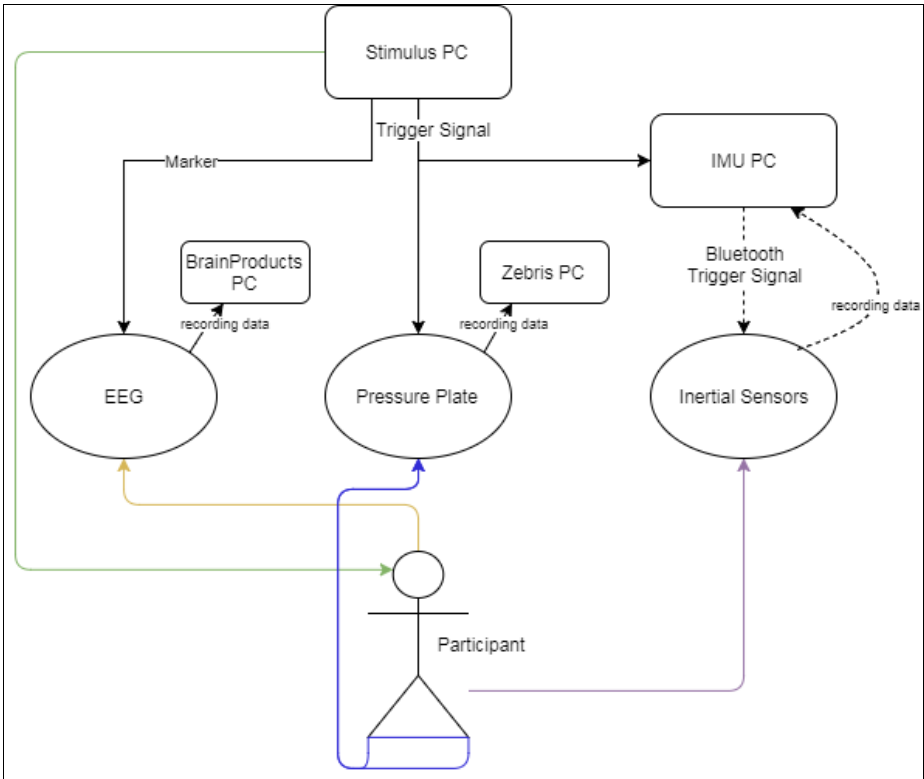
Figure 3. Structural design of the technical solution developed in this study. The solution includes the interfaces between the subsystems and recording devices. The stimulus PC can send triggers to the EEG, the pressure plate (treadmill), and the recording software of the inertial sensors (IMUs). Each system sends the recorded data to a corresponding PC.